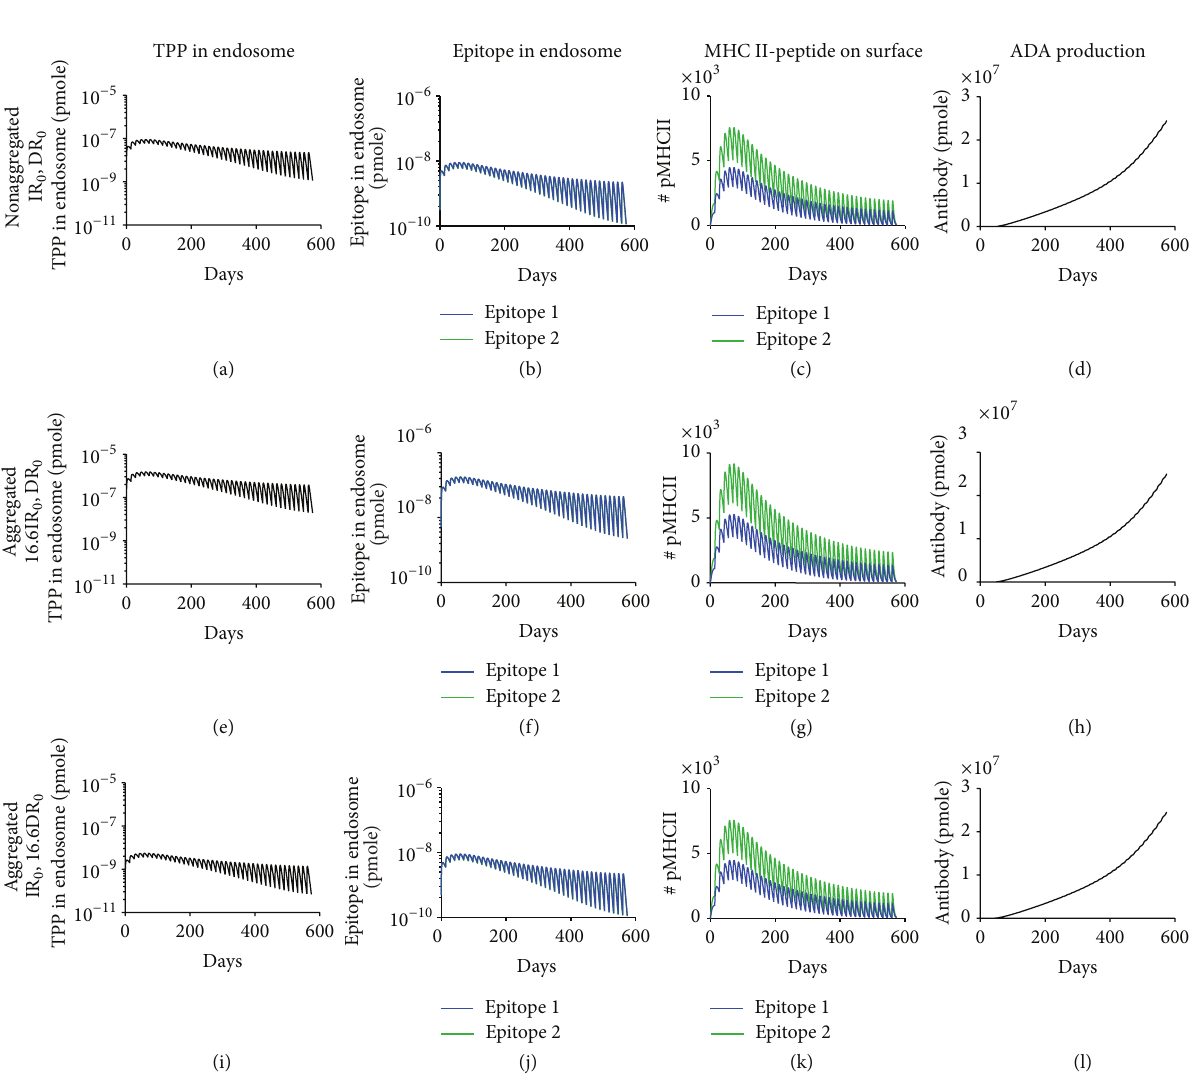
Figure 5: Aggregates could not enhance ADA production through faster antigen internalization or degradation if high affinity epitopes are already present in nonaggregated TPP. Simulated levels of nonaggregated and aggregated TPP in endosome, epitopes in endosome, MHC II-peptide complex on cell surface, and ADA production are shown for ((a)–(d)) original internalization (IR 0 = 14.4 day −1 ) and degradation (DR 0 = 17.28 day −1 ) rate for nonaggregated adalimumab [47, 48], ((e)–(h)) 16.6IR 0 and DR 0 for hypothetical aggregated form, and ((i)–(l)) IR 0 and 16.6DR 0 for hypothetical aggregated form. ADA production has the same definition and dose has the same value as in Figure